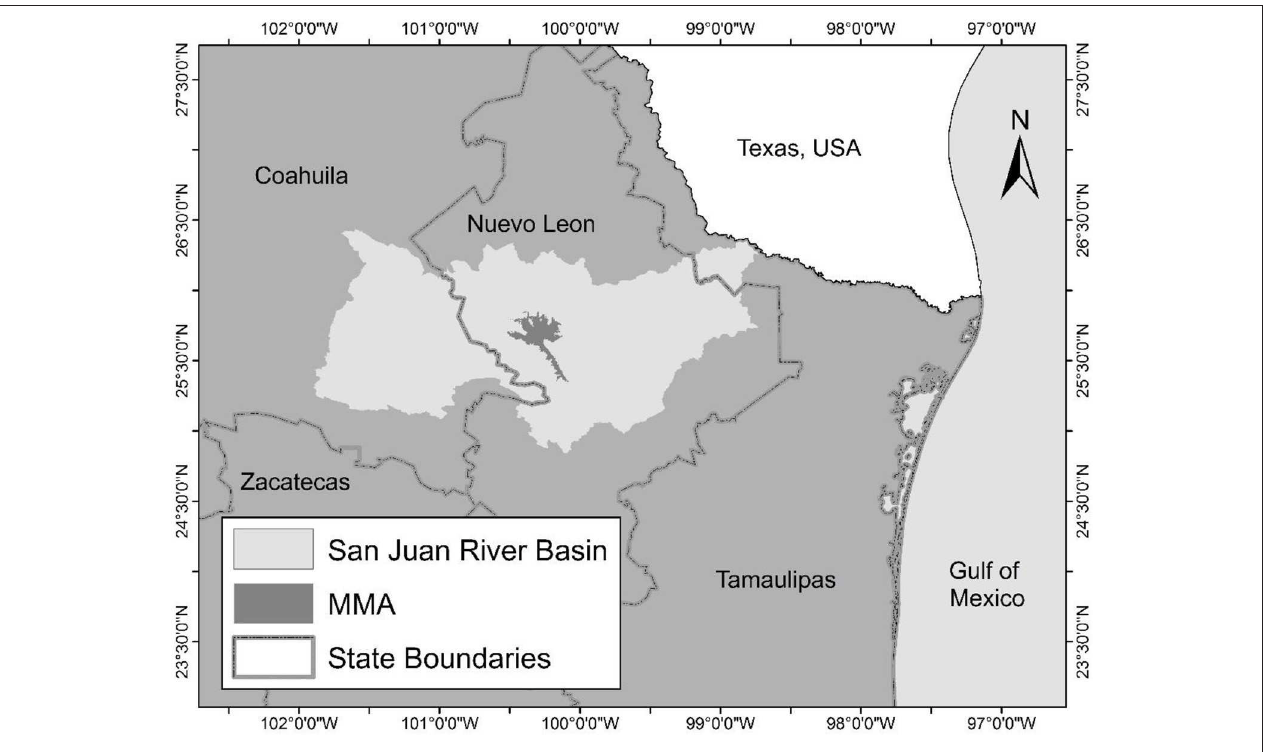
FIGURE 1 | Location of the Monterrey Metropolitan